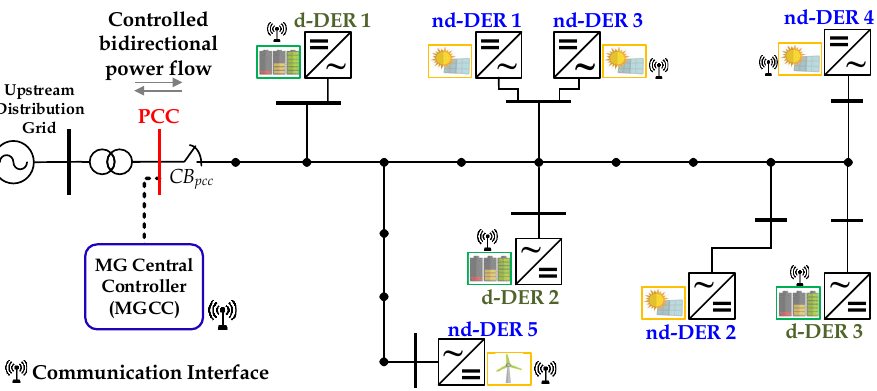
Figure 1. Example of a dispatchable MG interconnected to an upstream grid, comprising multiple DERs of assorted natures and different operational conditions, being managed by an